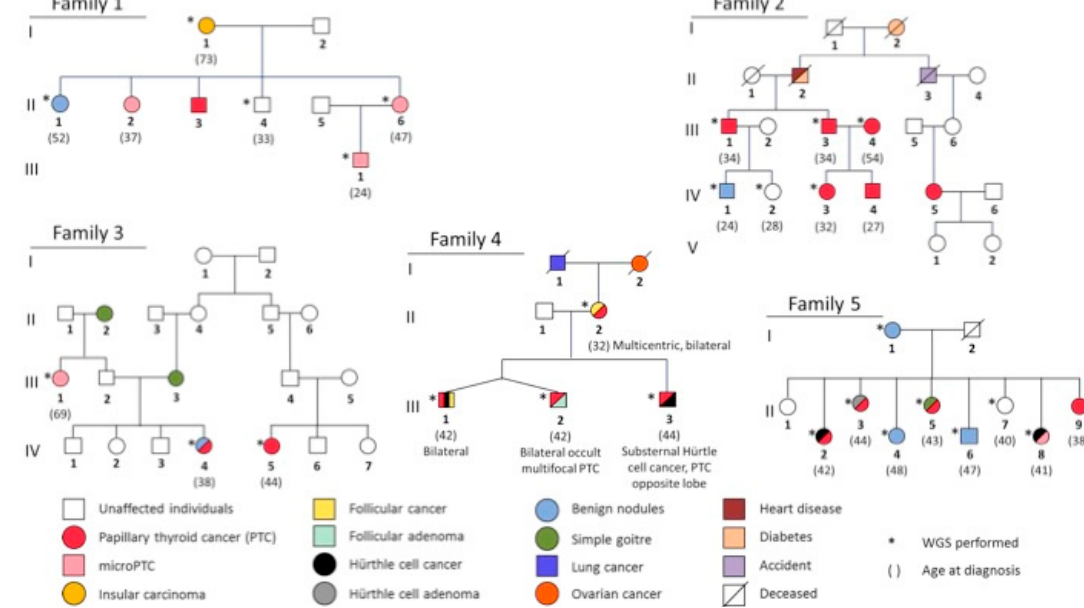
Figure 1. Pedigrees of the five non-medullary thyroid cancer (NMTC)-prone families analyzed in this study.